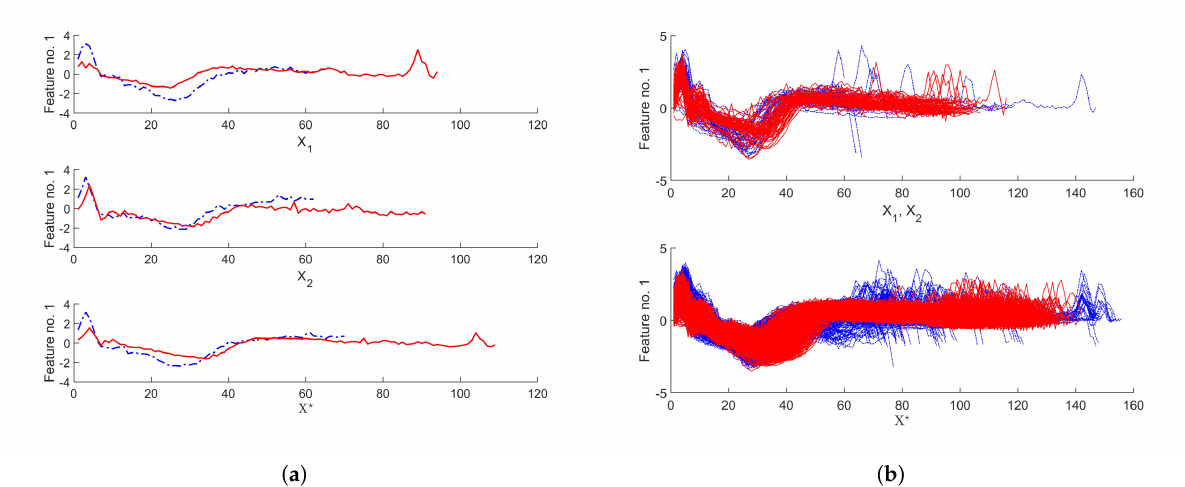
Figure 1. Augmented time-series from ECG dataset [25] using the proposed method. The first two rows show input time-series of two classes, the third row presents new examples ( a ). The plot for the entire ECG dataset highlights the variability of augmented time-series ( b ). Classes are indicated by